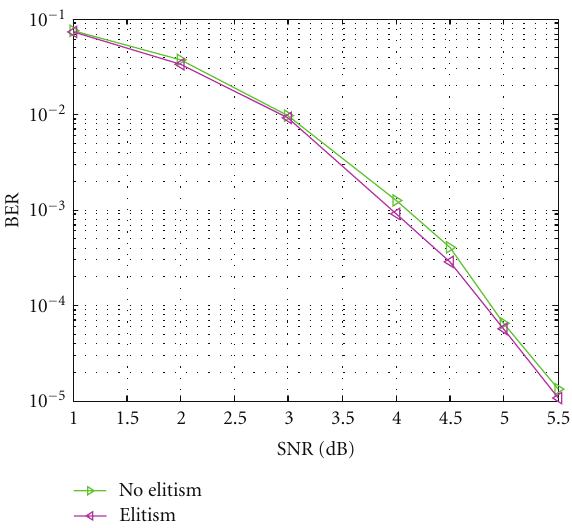
Figure 5: E ff ect of elitism operator on DDGA